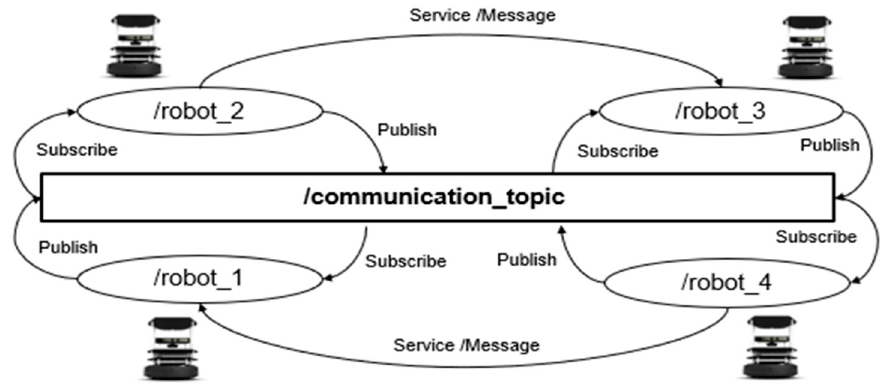
Figure 8. Interactions of swarm robots in the ROS environment.